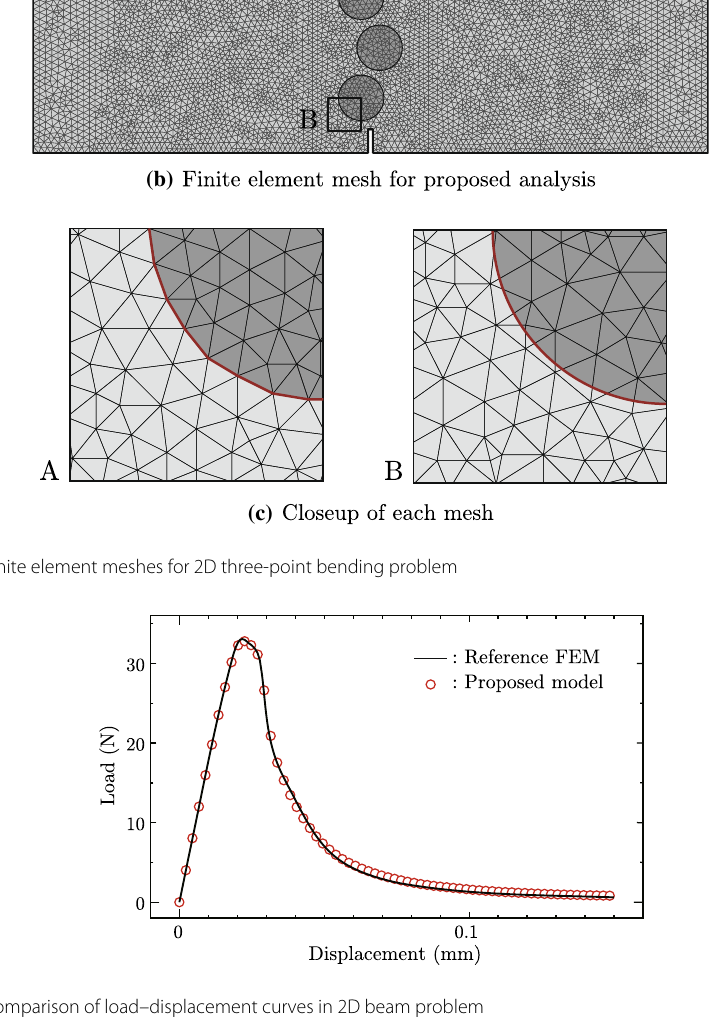
ment with the reference solution. This means that, in the same manner as for 2D problems, the proposed damage model is capable of evaluating the damage of the matrix-phase in composite materials using the volume fraction of the matrix within the